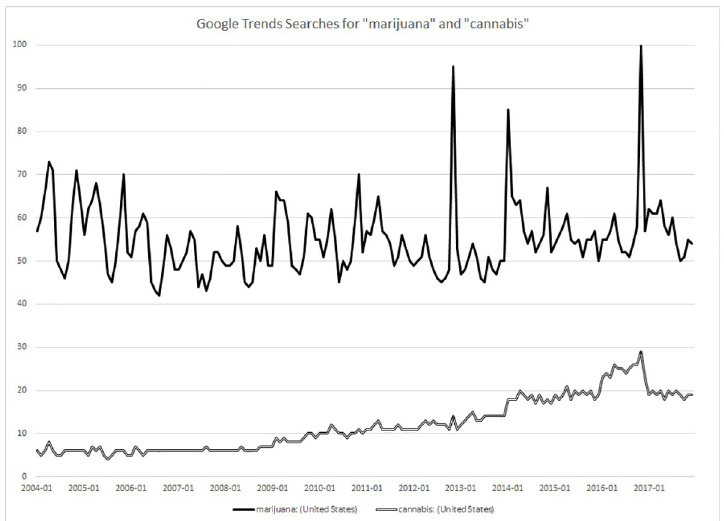
Fig 3. Relative popularity of “Cannabis” and “Marijuana” in Google searches in the United States, 2004–2017. Source : Google Trends query, June 22, 2018.